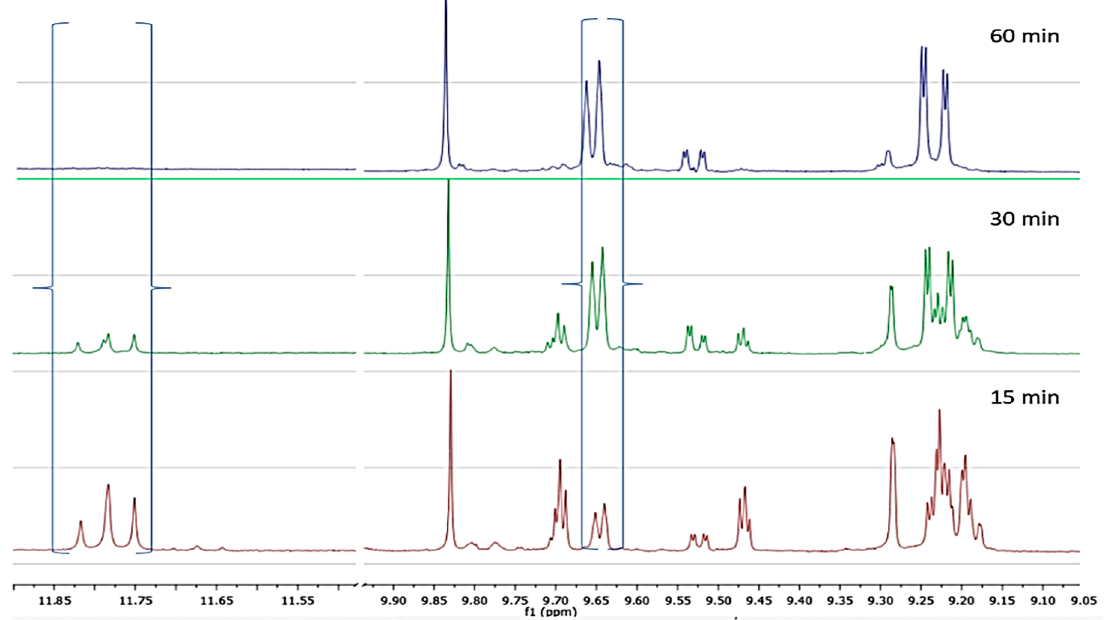
Figure 8. NMR profile of cv Koroneiki at 28 °C, at three malaxation times, showing the characteristic peaks of the analyzed phenolic compounds.